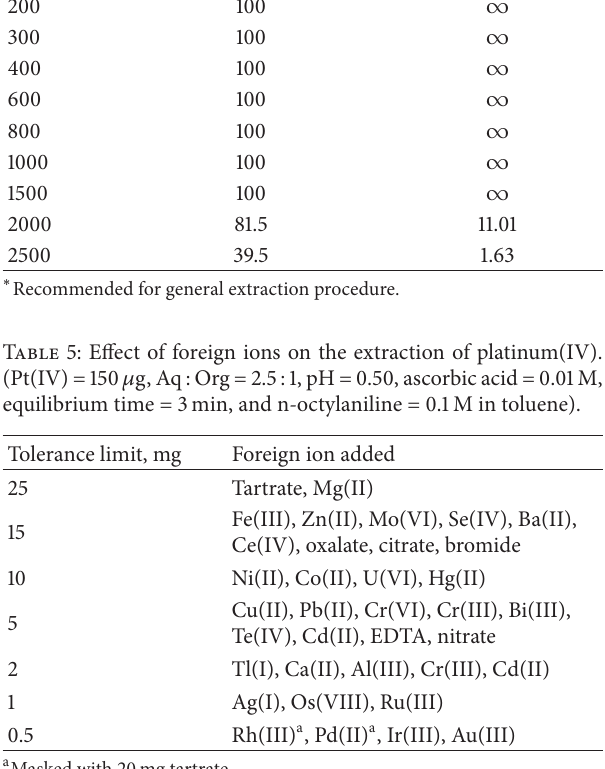
Figure 4: Log-log plot of distribution ratio 𝐷 [ at fixed n-octylaniline concentration. Log 𝐶 [ ascorbate ]